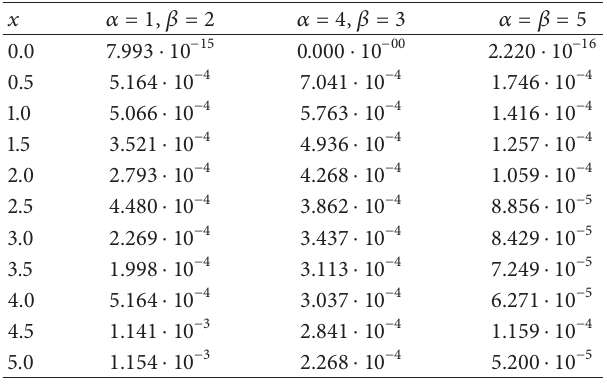
Table 1: Absolute errors using MGLC method at 𝑁 = 22 for Example 1.